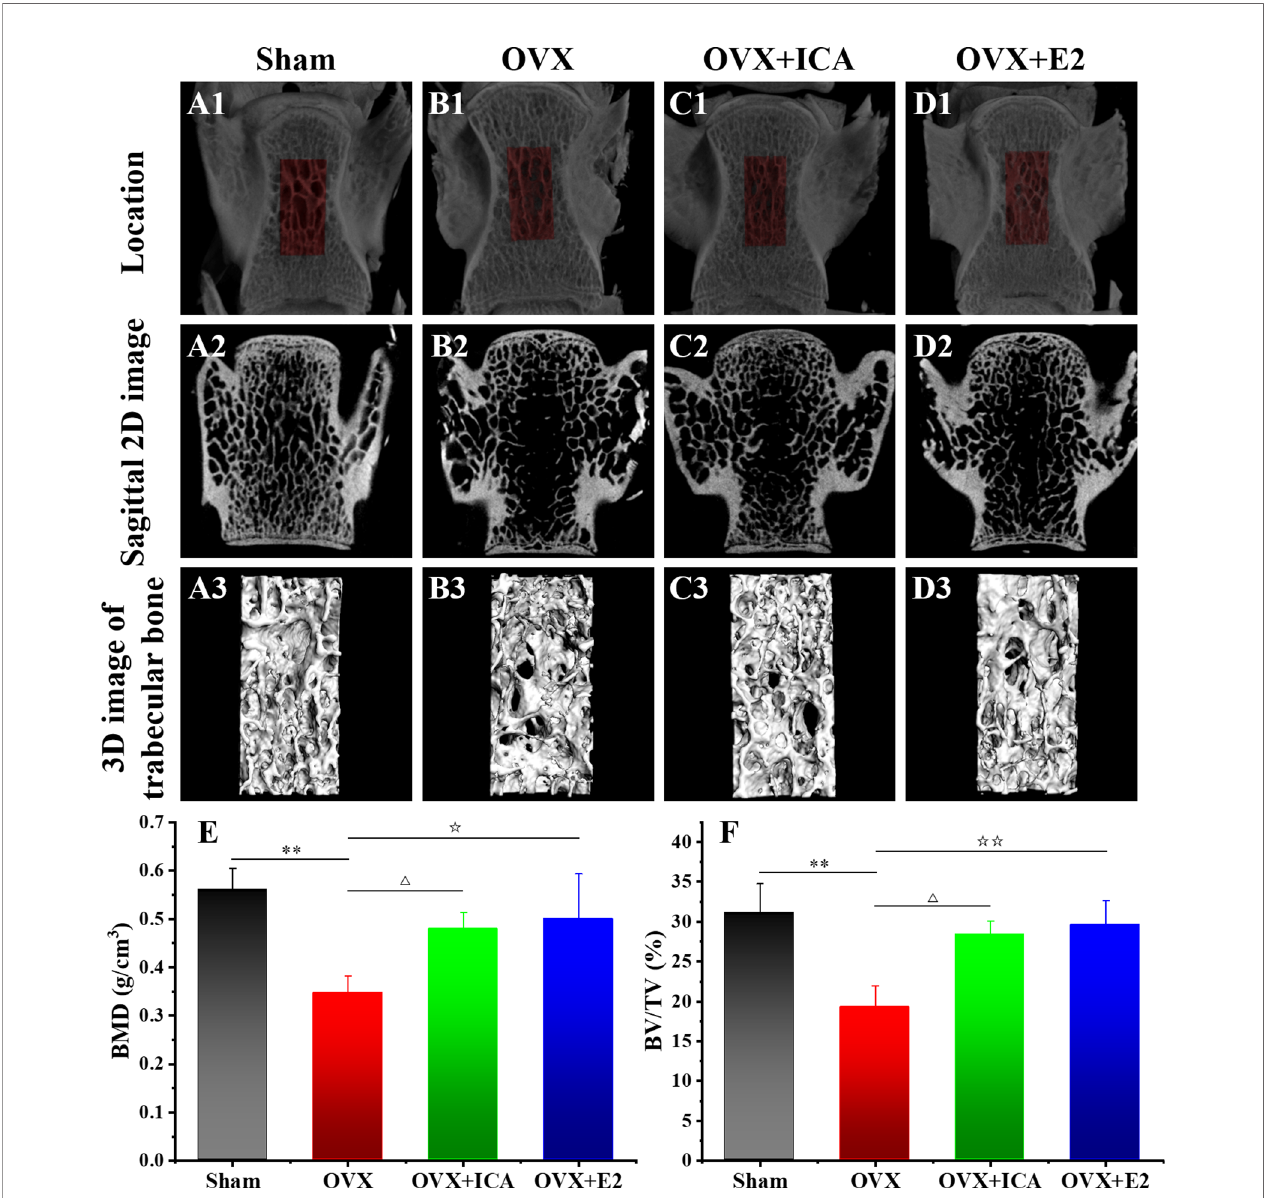
FIGURE 1 | Therapeutic effects of different treatments on the bone histomorphometry of PMOP model. Micro-CT images of the bone structure for Sham (A1 – A3) , OVX (B1 – B3) , OVX+ICA (C1 – C3) and OVX+E2 (D1 – D3) (n = 6). Morphometric analysis of BMD (E) and BV/TV (F) in local area (three samples per group at each time point). △ , ☆ p < 0.05, ☆☆ , ** p <